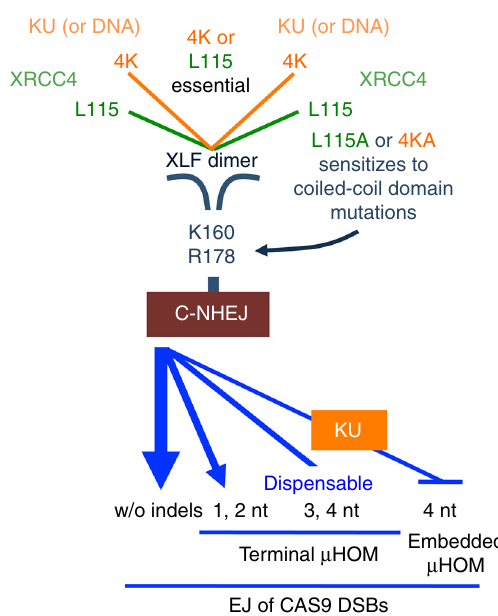
Fig. 7 Summary. Shown is a model for the function of distinct XLF domains during C-NHEJ, as well as the role of C-NHEJ in distinct EJ